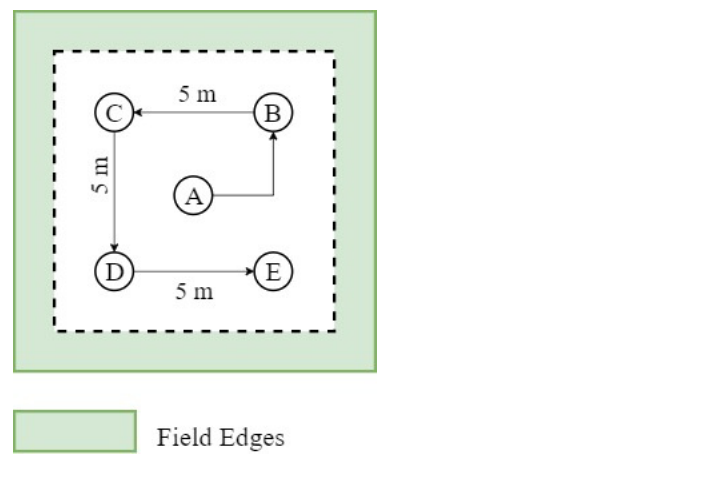
Figure 3 . LAI measurement approach for each visited field during 2018 growing season. Figure 3. LAI measurement approach for each visited field during 2018 growing